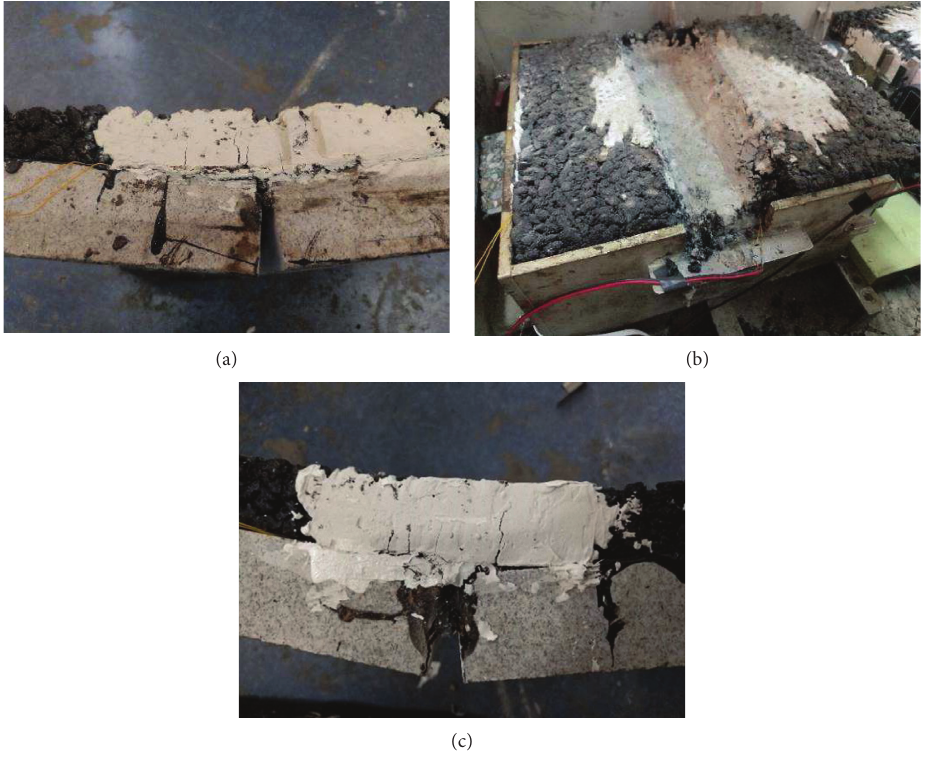
Figure 2: Cracking patterns of specimens based on various treatment schemes. (a) Treatment specimen of the macromolecule polymer crack paste. (b) Treatment specimen of the high elastic stress absorption band. (c) Treatment specimen of the crack pouring.